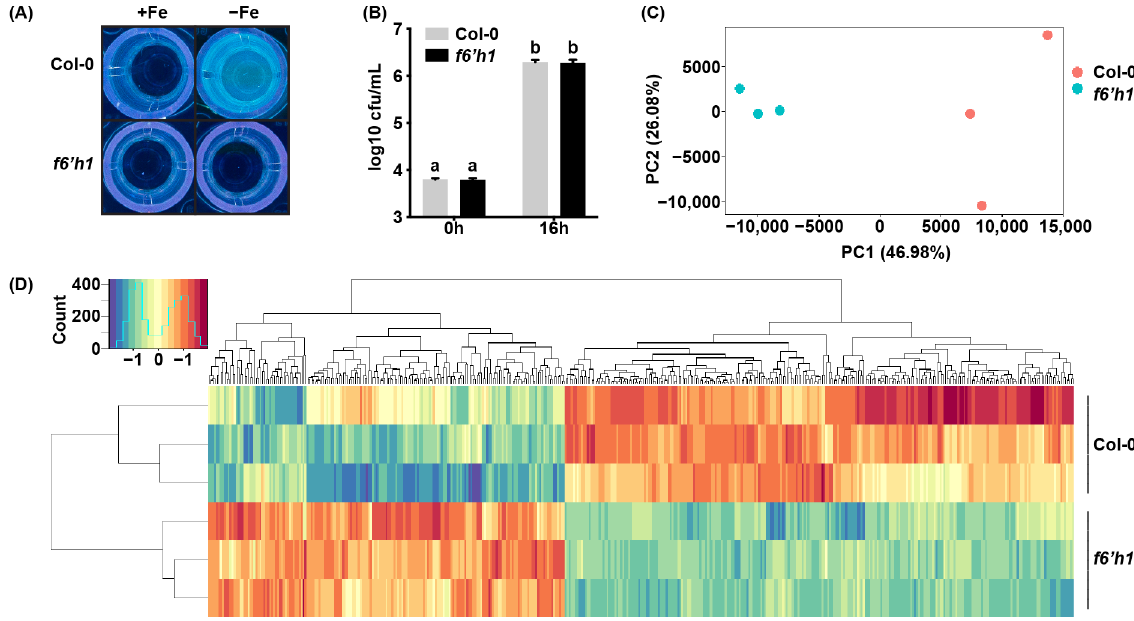
Figure 1. WCS417 transcriptome responds to F6 ′ H1-dependent coumarins in Arabidopsis root exudates. ( A ) Accumulation of fluorescent phenolic compounds in root exudates collected from Col-0 and f6 ′ h1 seedlings that were pre-grown in the Hoagland medium with (+Fe) or without ( − Fe) iron. Photos of fluorescence were taken under UV light (365 nm). ( B ) Growth of WCS417 in root exudates collected from coumarin-producing Col-0 and non-producing f6 ′ h1 seedlings that were pre-grown in the Hoagland medium without iron. The data shown are means of five biological replicates. Error bars represent standard errors of the mean (SEM). Letters indicate statistically significant differences (two-way analysis of variance (ANOVA) followed by Tukey’s test, p < 0.05). ( C ) Principal component analysis (PCA) of transcripts per million (TPM) counts of all 5545 WCS417 genes obtained from RNA sequencing (RNA-seq) results of the WCS417 transcriptome in response to root exudates from iron-starved Col-0 and f6 (cid:48) h1 seedlings. ( D ) Heatmap and hierarchical clustering of TPM retrieved from 439 differentially expressed genes (DEGs) that are affected by F6 (cid:48) H1-dependent root exudates. TPM were centered and scaled. DEGs and Arabidopsis genotypes were organized according to hierarchical clustering using the complete linkage